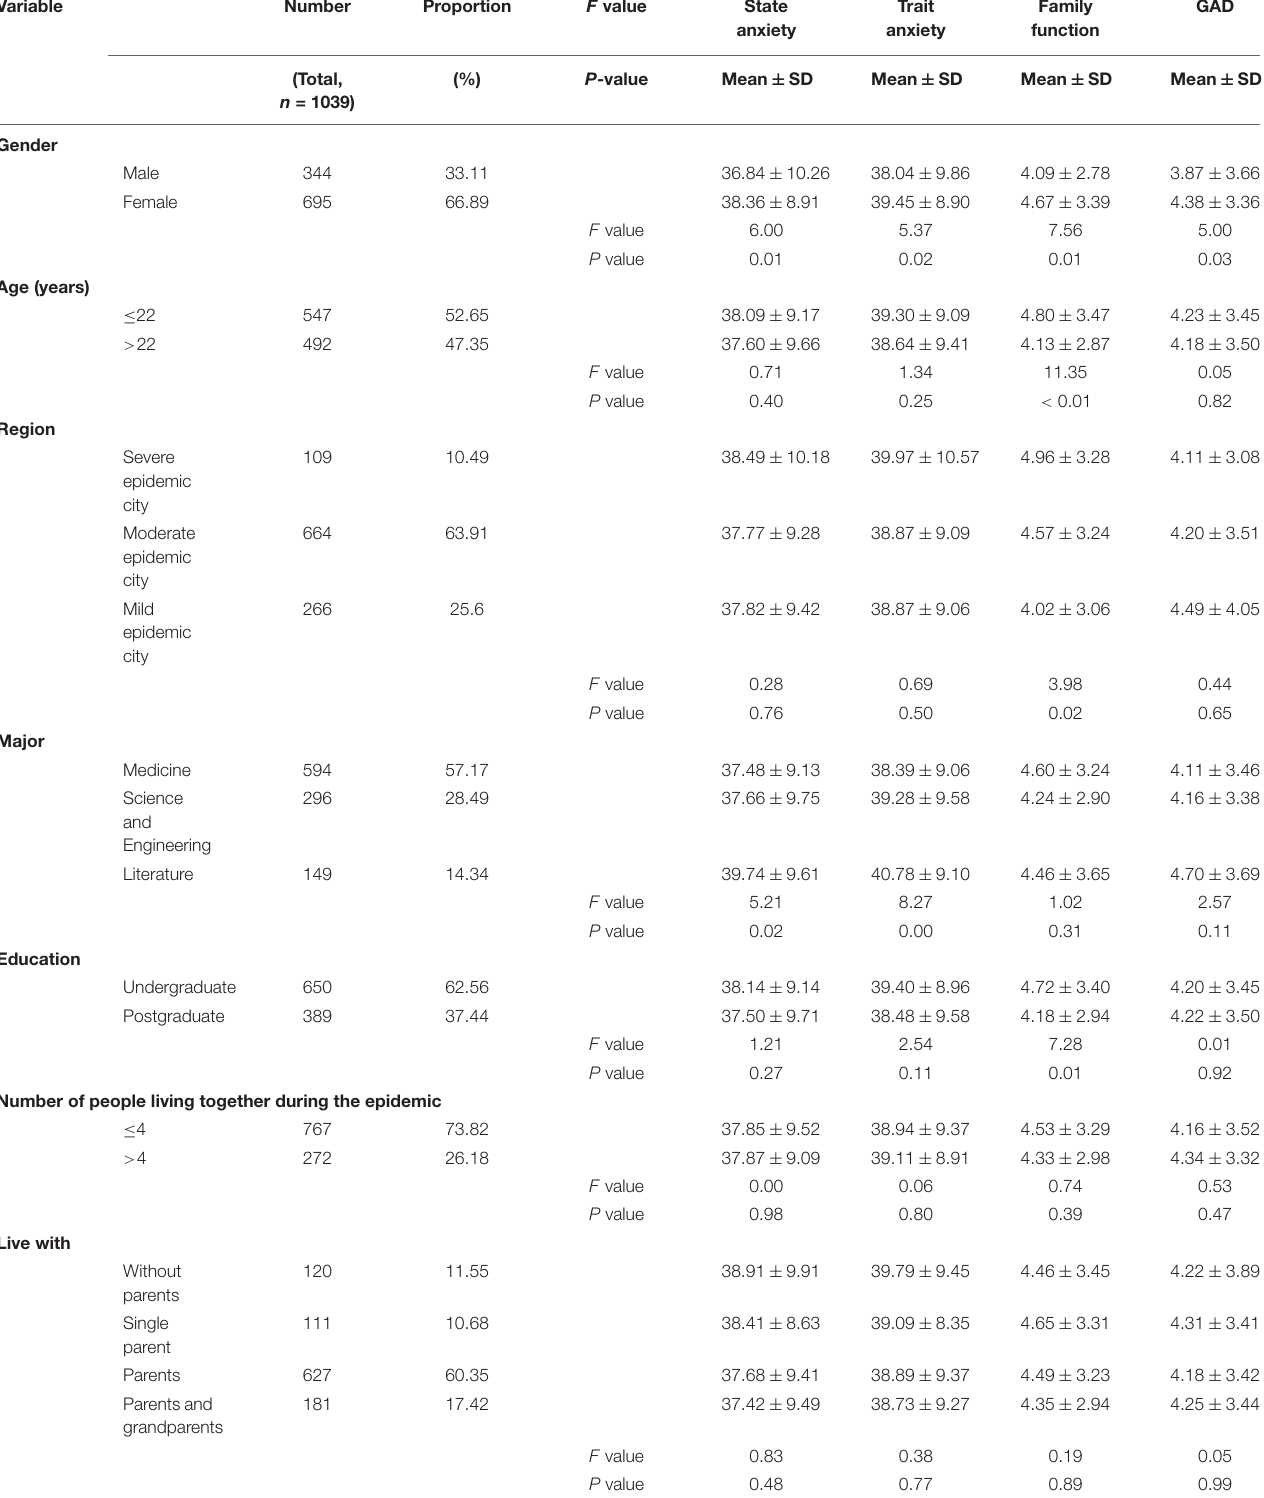
TABLE 1 | The demographic characteristics and ANOVA results of the respondents. Variable Number Proportion F value State